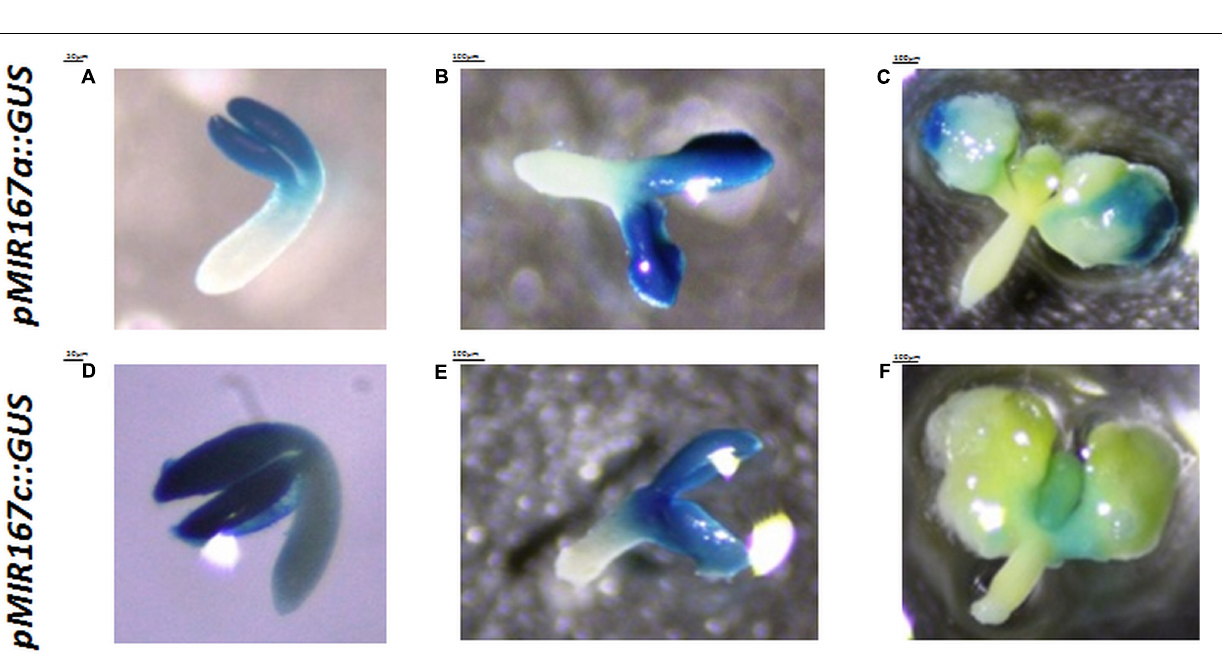
Frontiers in Plant Science |